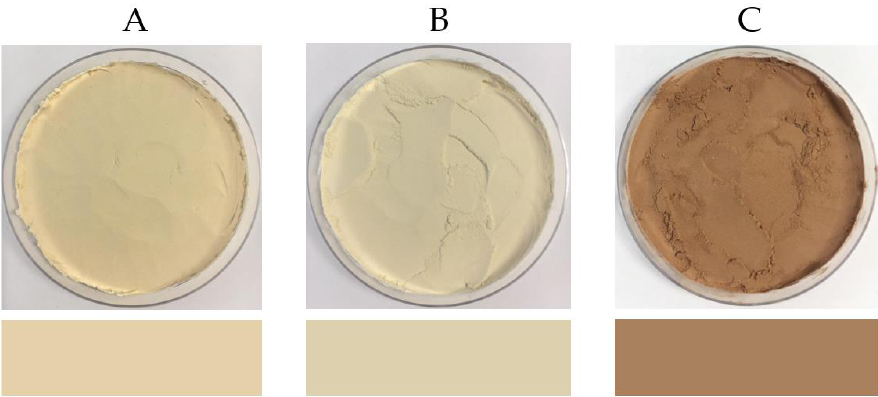
Figure 2. Images of PPI ( A ), SPI ( B ), and EverPro ( C ), alongside a digital visualisation of the L*a*b* values for each sample.